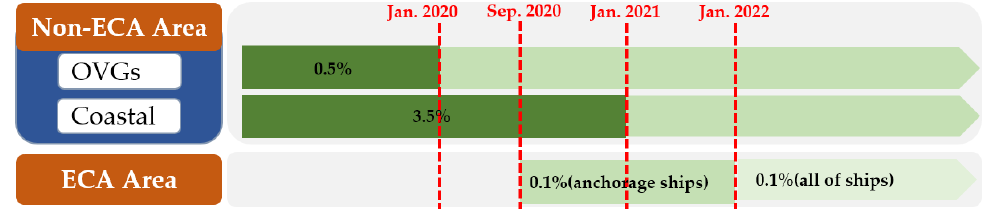
Figure 1. The sulfur limit status of South Korea. Source: Ministry of Oceans and Fisheries (MOF), 2020.